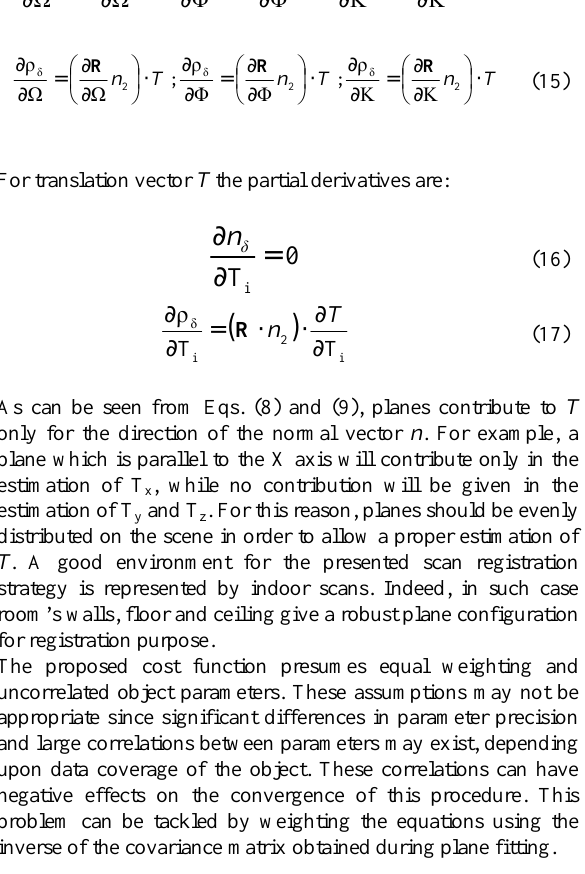
Table 1. Technical specifications of the adopted FARO-FOCUS 3D laser scanner.